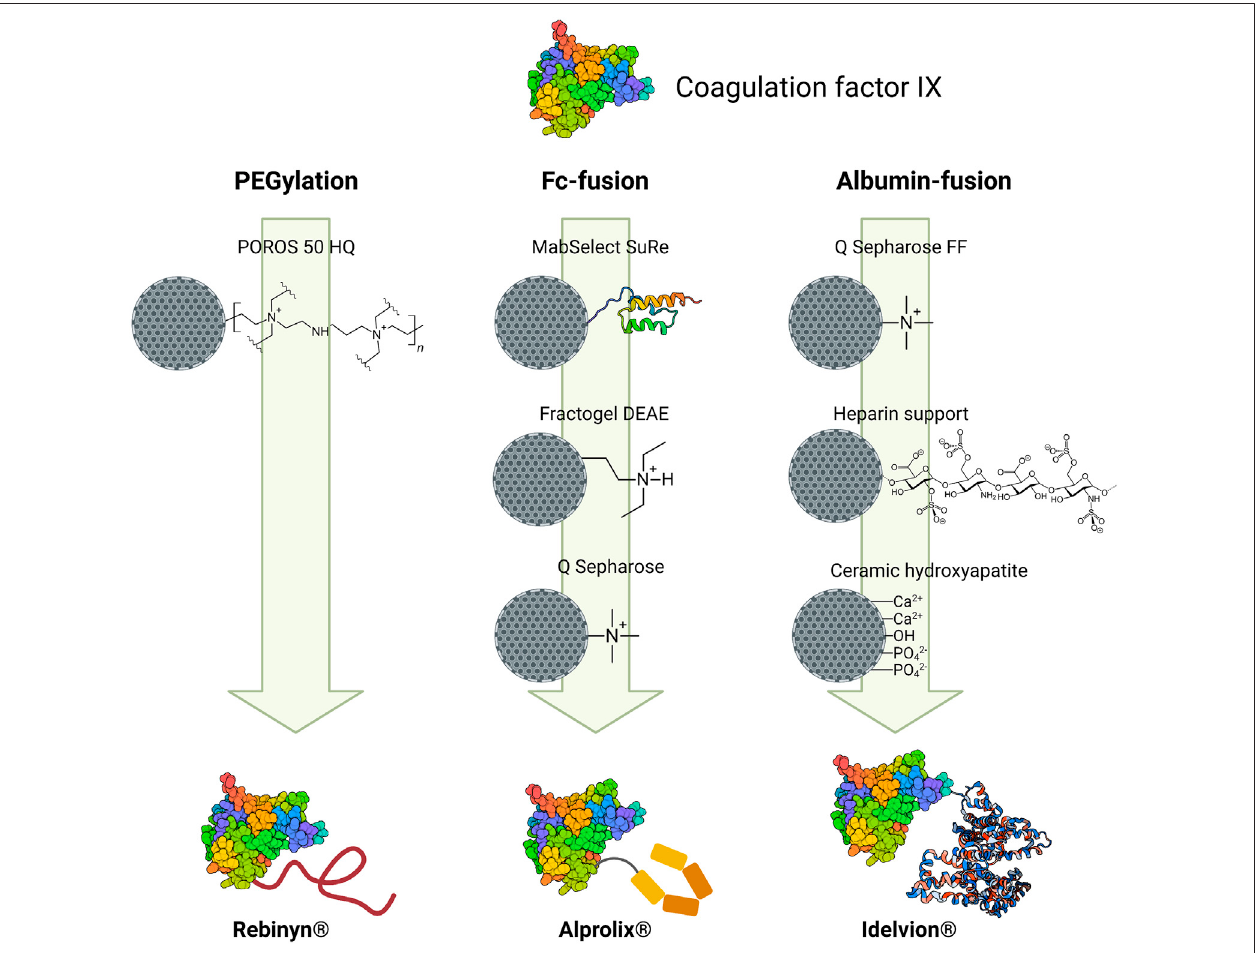
FIGURE5| Chromatographicstrategiesfollowedtopurifythethreedifferentversionsofmodi fi edcoagulationfactorIX.Foreachmodi fi cation,resins(depictingtheir ligands) areplacedinorderaccordingtothedownstreamprocess. Themodi fi edproteins representations areillustrative,and theydonotre fl ecttheactuallocationofthe